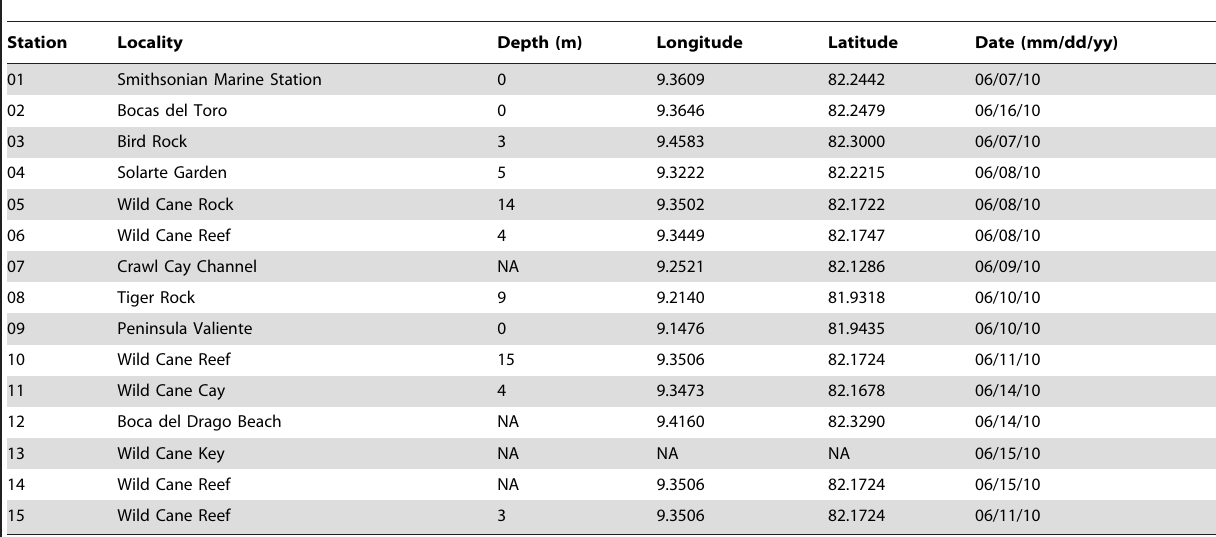
Depth, coordinates and date of sampling are indicated. NA= not available. doi:10.1371/journal.pone.0104385.t002 PLOS ONE |